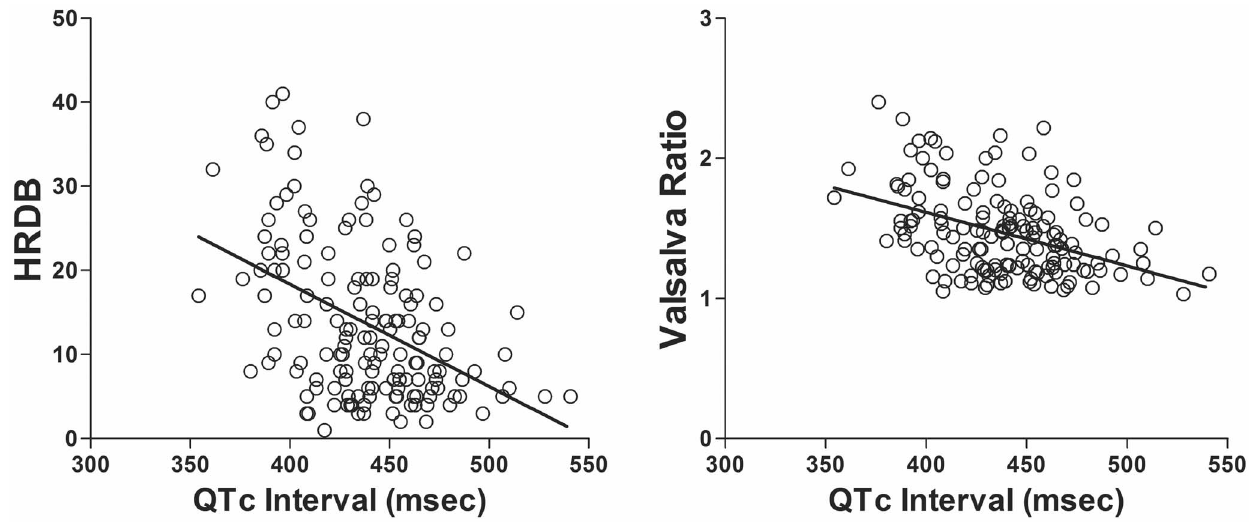
Figure 5. Correlation of corrected QT interval with heart rate response to deep breathing and Valsalva ratio. The corrected QT (QTc) interval showed negative correlations with HRDB ( r = 2 0.443, p , 0.001, left panel) and Valsalva ratio ( r = 2 0.425, p , 0.001, right panel). In the partial correlation analysis controlling for age, associations between QTc interval and HRDB ( r = 2 0.364, p , 0.001), and QTc interval and Valsalva ratio ( r = 2 0.336, p , 0.001) remained statistically significant.